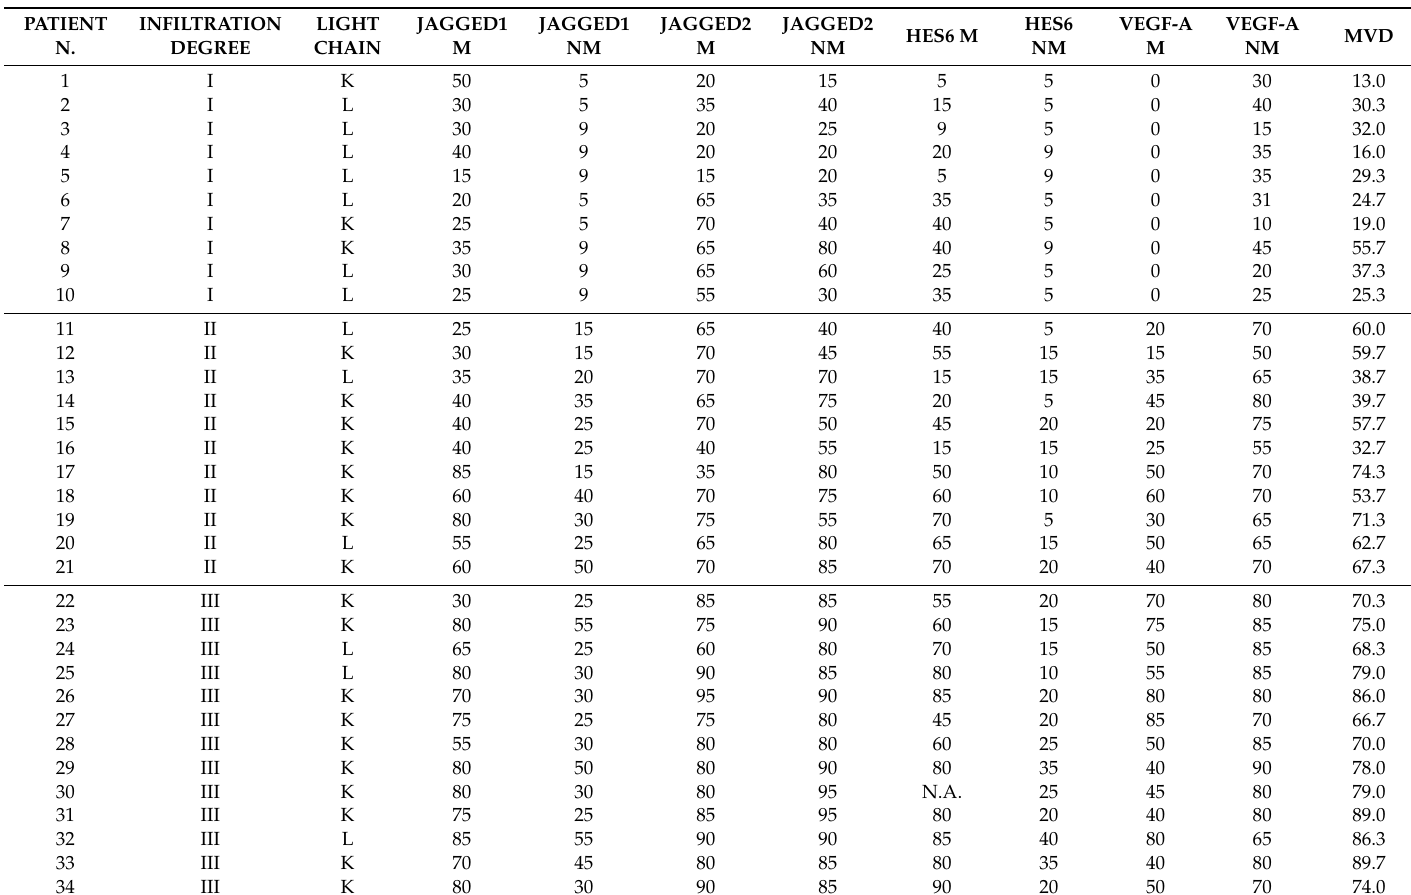
Table 1. Immunohistochemical analysis of the Jagged ligands, Notch activation and angiogenesis in MM patients’ bone marrow biopsies (BMBs). The degree of malignant plasma cell infiltration in the BM is reported along with the antigen immunoreactivity for monoclonal or Ig light chains. Additionally, the percentage of immunoreactive cells out of the total cells for Jagged1 and 2, HES6 and VEGF-A is reported both for MM (M) and non-MM (NM) cells, along with the microvessel density (MVD) evaluated as the average number of cell determinant 34 + (CD34 + ) vessels per field. PATIENT